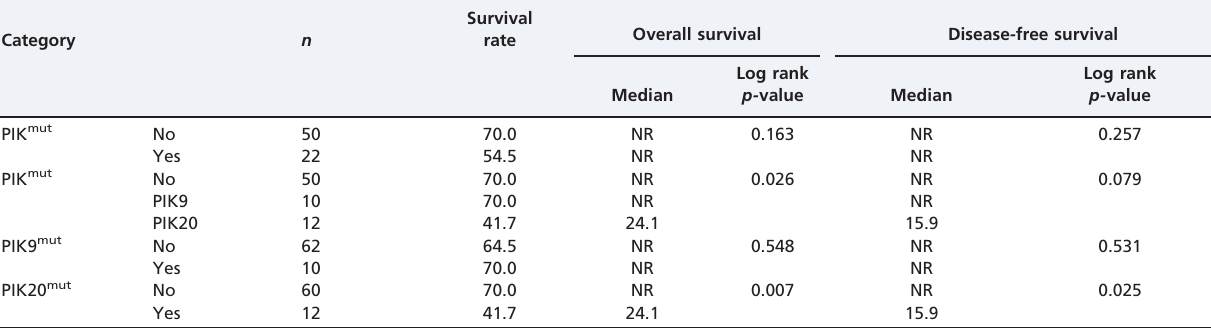
Survival rate Overall survival Disease-free